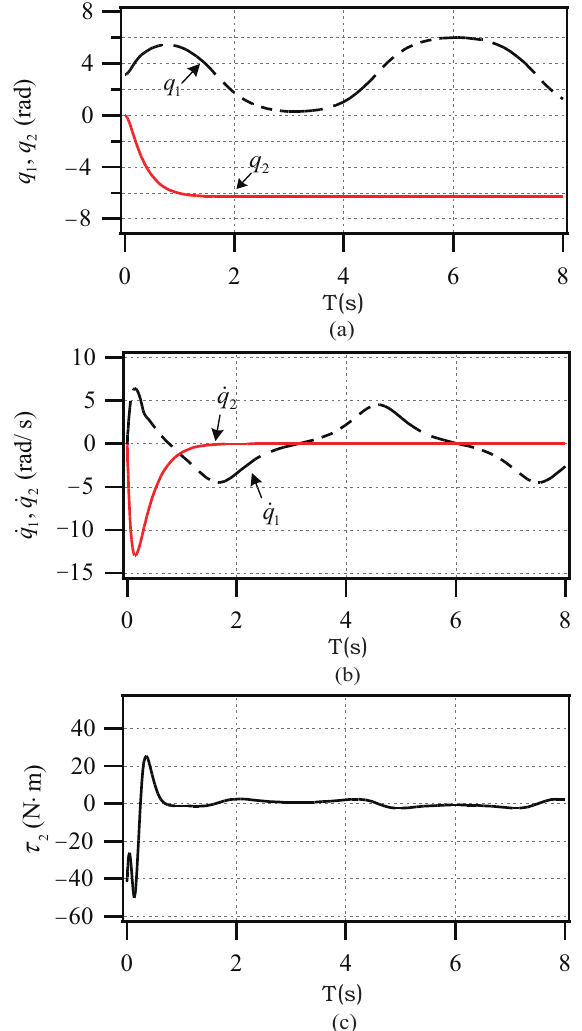
Figure 4. Simulation results with (23): ( a ) angle; ( b ) angular velocity; ( c )